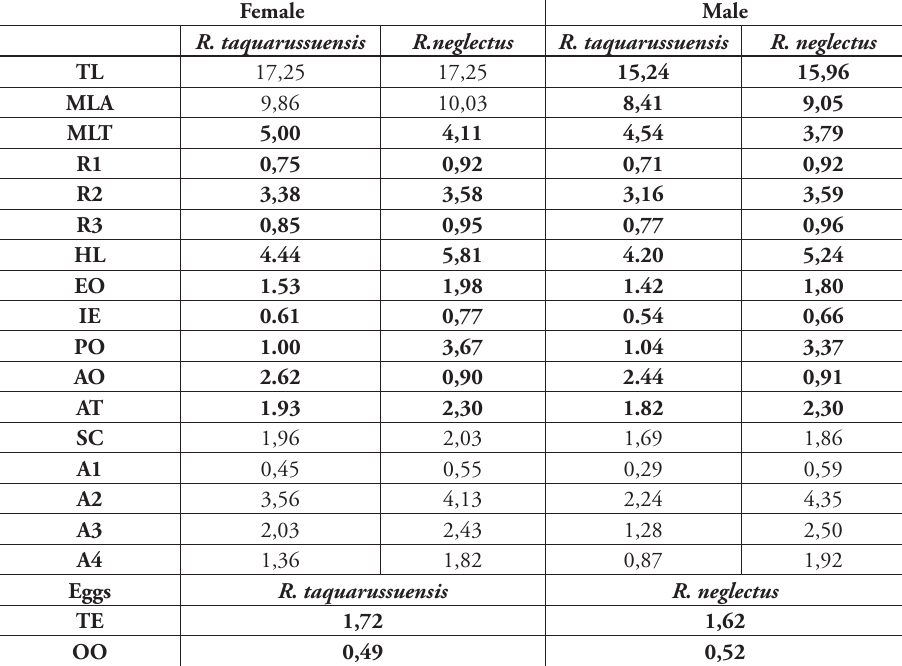
Eggs R. taquarussuensis R. neglectus TE 1,72 1,62 OO 0,49 0,52 *30 eggshells were used for each